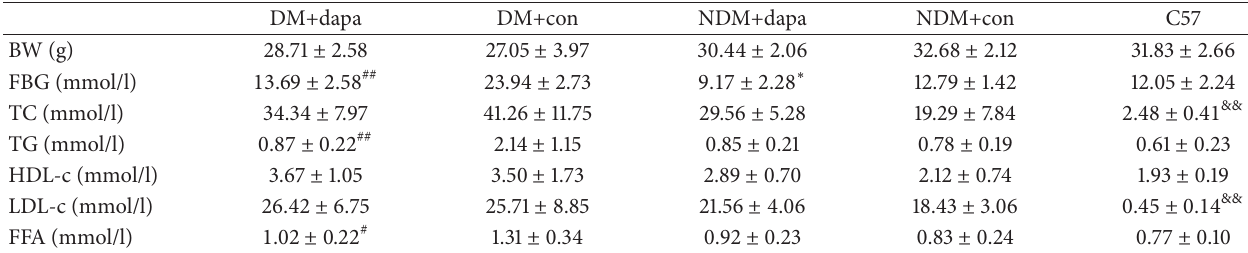
Figure 1: Changes of metabolic parameters in mice from each group. (a) and (c) Compared with non-DM group, the blood glucose in DM group was significantly increased; and dapagliflozin treatment of 12 wks significantly decreased blood glucose in both groups; (b) and (d) no significantchangesofbodyweightweredetectedbeforeandafterdapagliflozintreatmentineachgroup;(e),(g),and(h)thelevelsofcholesterol were significantly increased in the ApoE −/− mice fed with a high-fat diet, particularly in DM ApoE −/− mice. Dapagliflozin treatment did not reduce the levels of TCH, HDL-c, or LDL-c; (f) and (i): dapagliflozin treatment decreased the levels of TG and FFA. ∗ , 𝑝 < 0.05 ; ∗∗ , 𝑝 < 0.01 ; ##, 𝑝 < 0.01 . Table 1: Data on body weight, fasting blood glucose, and blood lipid profile in all